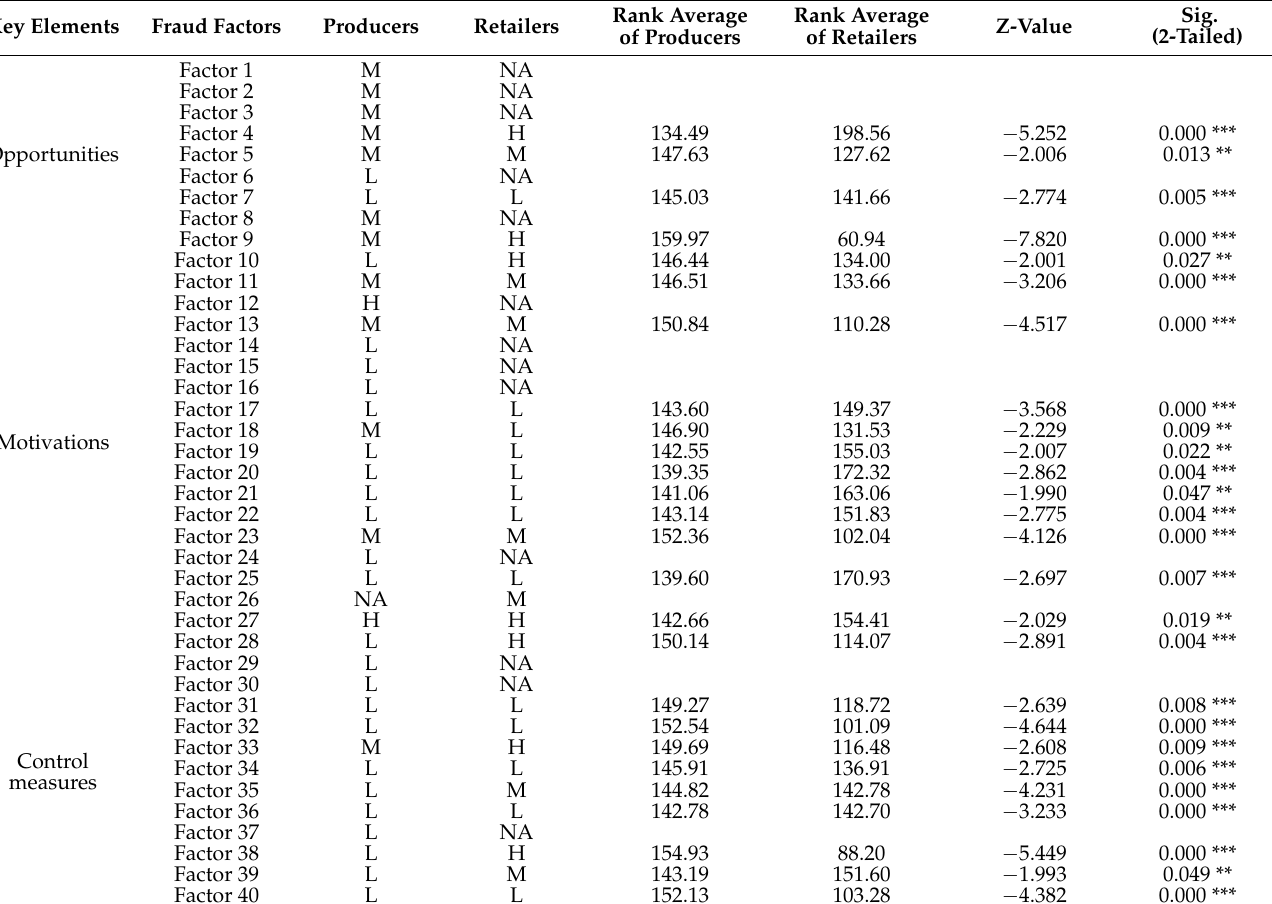
Table 3. Vulnerability of different groups to fraud factors and Mann-Whitney U test.